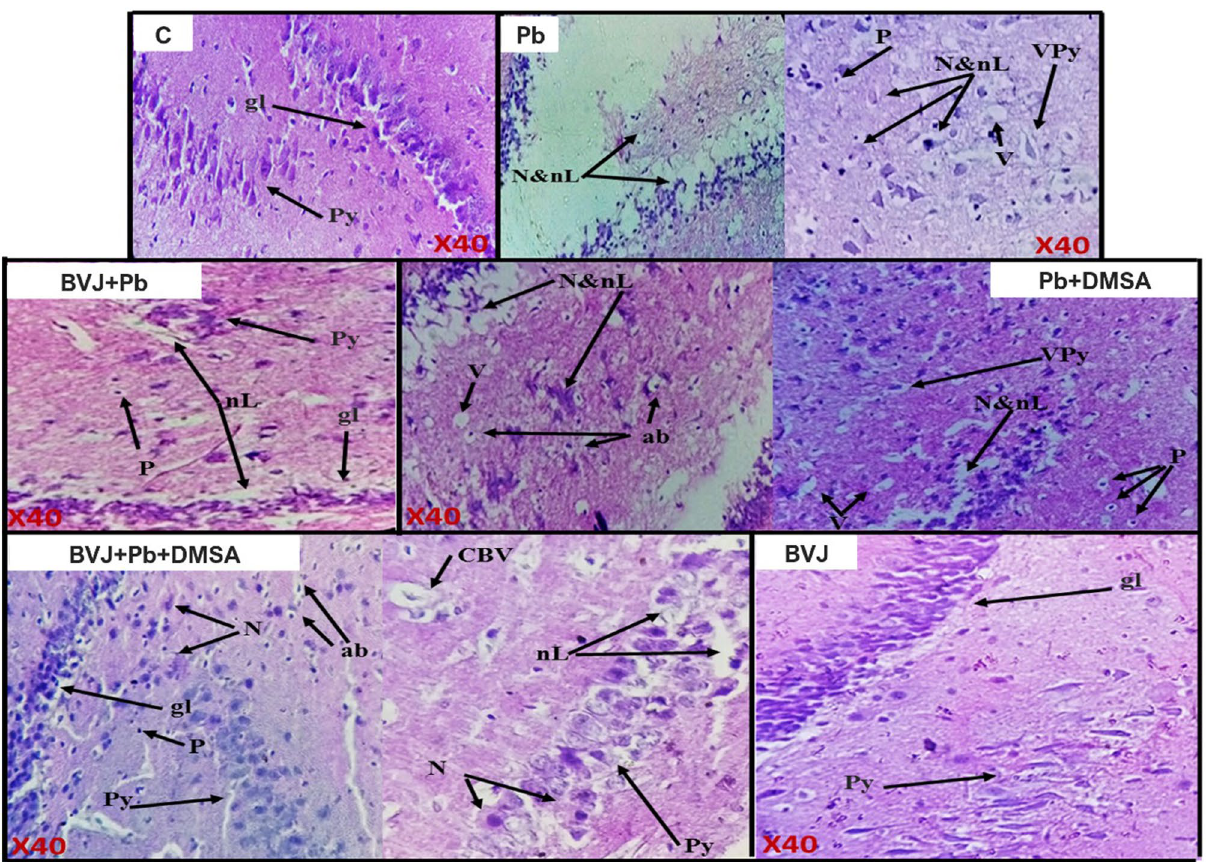
Figure 6. Representative photomicrographs of the hippocampus in the brain of control (C) and Pb-intoxicated rats with and without administration of Beta vulgaris juice (BVJ), dimercaptosuccinic acid (DMSA), or their combination (BVJ + DMSA). ab apoptotic bodies, CBV congested blood vessel, gl granular layer, N necrosis, nL neuronal loss, P pyknosis, Py pyramidal cells, V vacuolization, VPy vacuolized pyramidal cells, × 40 magnification of the